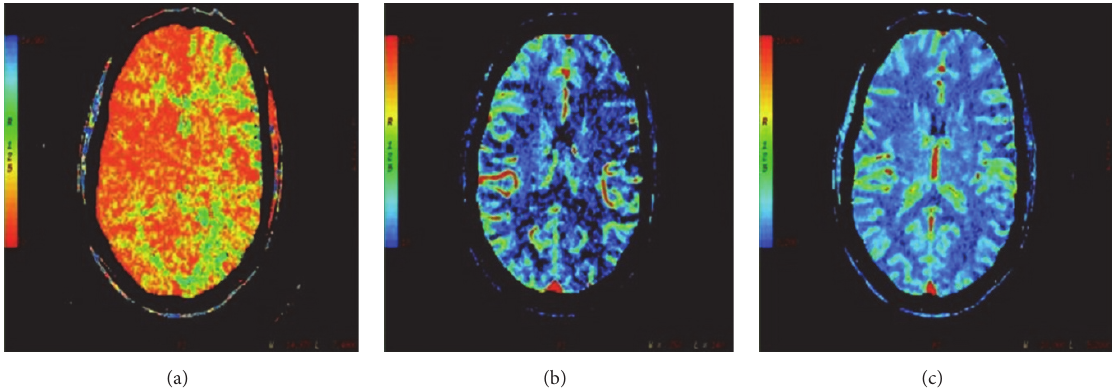
Figure 1: Perfusion computed tomography. TC revealed increased mean transit time (a) and diminished cerebral blood flow (b) with preserved cerebral volume (c). These changes were observed throughout the entire left cerebral hemisphere not confined to a particular vascular territory including the territory of anterior, middle, and posterior cerebral arteries